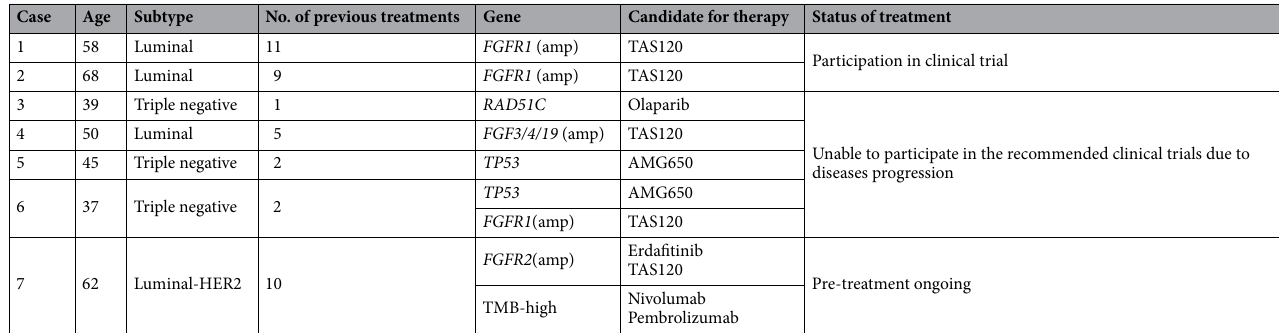
Table 2. Molecular tumor board treatment recommendations.